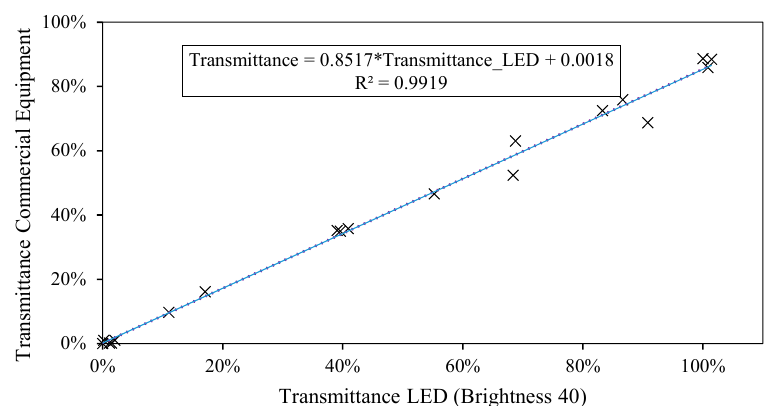
Figure 9. Scatter diagram between reference transmittance value and the most suitable brightness level (T40).